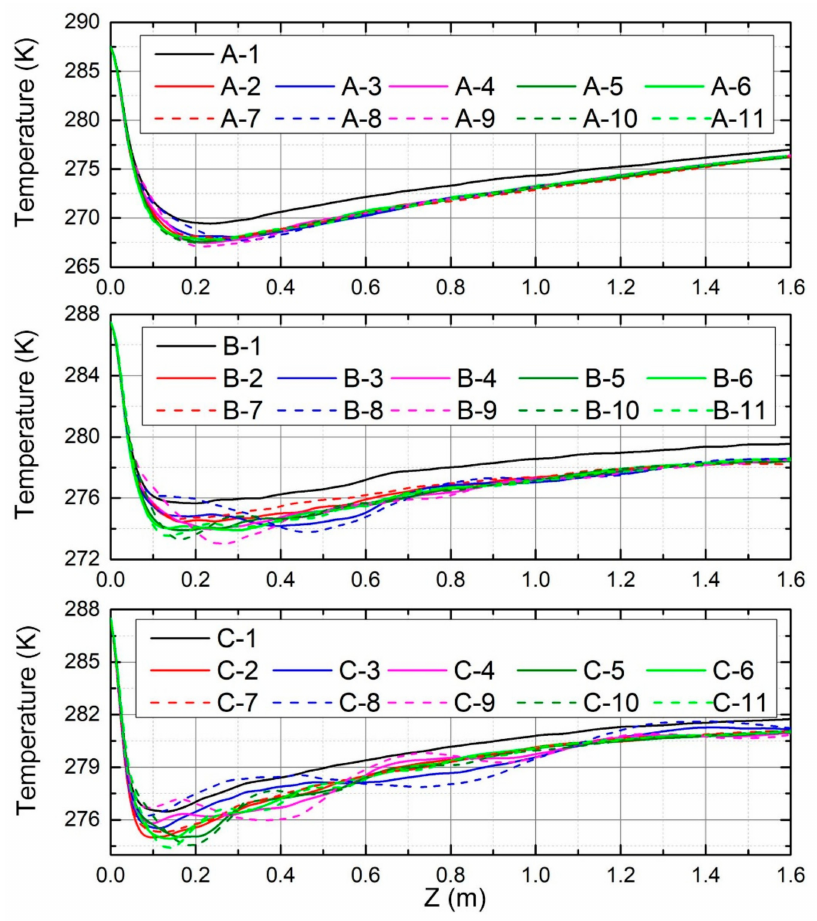
Figure 11. Temperature along center lines of computational